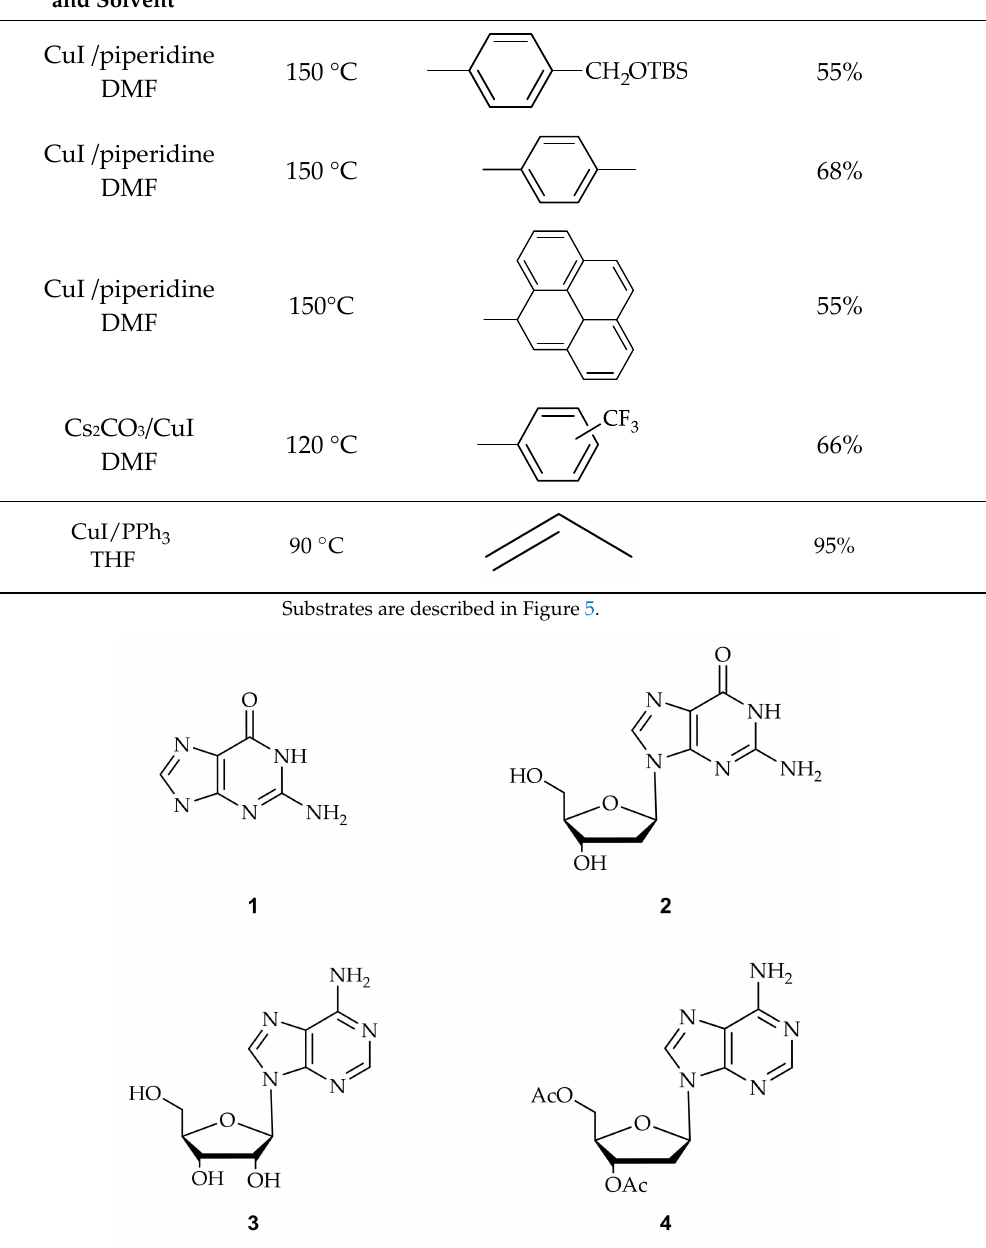
Figure 5. Purines substrates ( 1 : guanine, 2 : 2’-deoxy guanosine, 3 : 2’-ribose adenosine, and 4 : 3’,5’-di- O-acetyl-2’-deoxy adenosine) are involved in the acylation employed by palladium